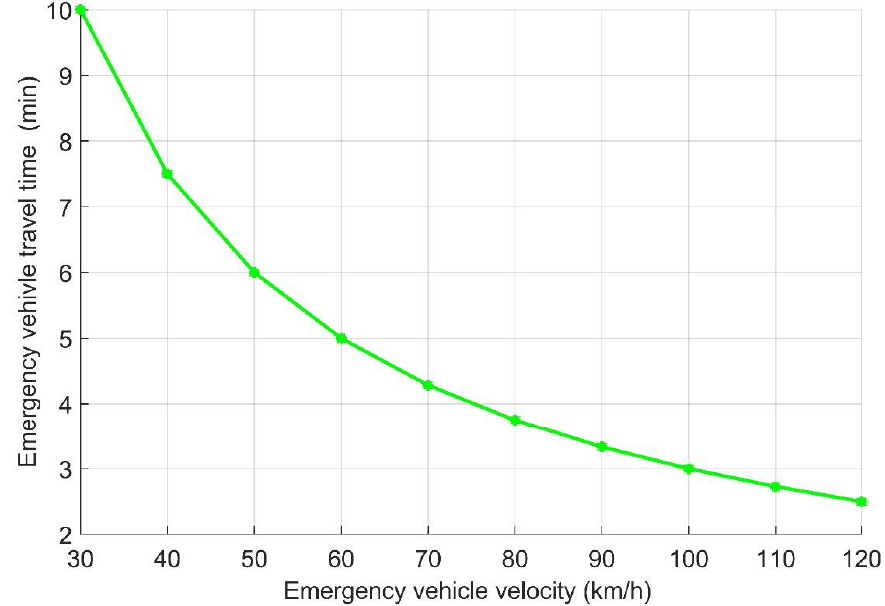
Figure 9. Emergency vehicle travel time versus emergency vehicle velocity.